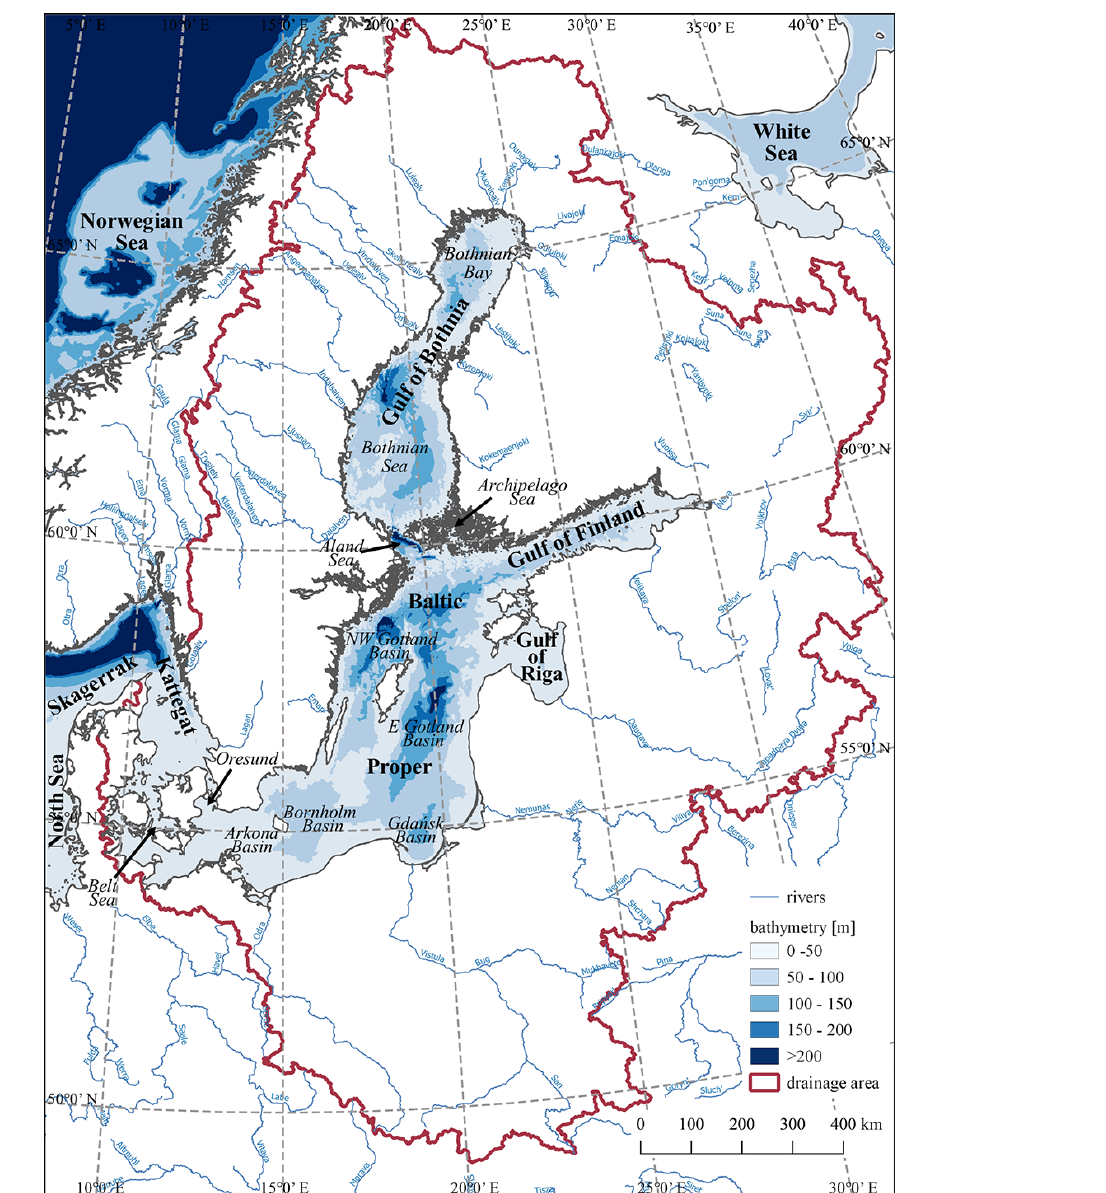
Figure 1. The Baltic Sea and its